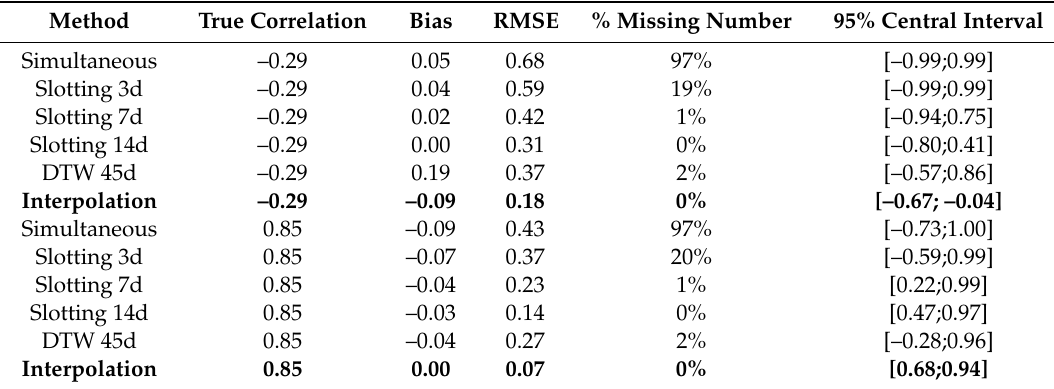
Table 1. Descriptive statistics of the CC estimators for the simultaneous observations, the slotting method with three di ff erent bin sizes, DTW with a Sakoe–Chiba band of 45 days, and the interpolation method and for both examples.